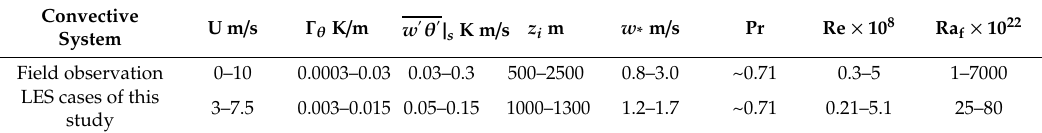
Table 2. Typical field-observed values of the key parameters in CBL, obtained by Hibberd and Sawford [36] and their counterparts in the LES cases of the current study. Note: Pr, Re and Ra f are the Prandtl number, Reynolds number, and the flux Rayleigh number, respectively. Pr = ν / α , Re = Uz i / ν , and Ra f = B s z 4 / ν D 2 s , where D s is the coe ffi cient of di ff usion. i Convective U m / s Γ θ K / m w (cid:48) θ (cid:48) | s K m / s z i m w * m / System